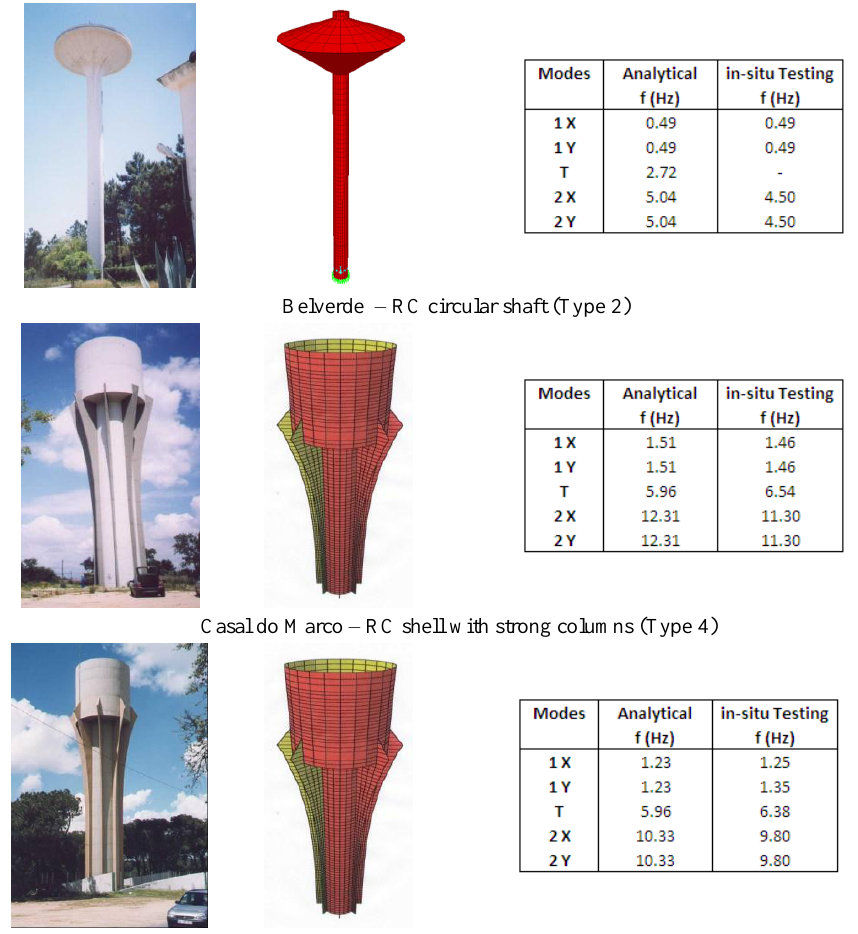
Fig. 6. Comparison between the analytical and in-situ testing frequencies. (The standard deviation of the analytical model is zero because materials and geometry are treated as deterministic; for the in-situ testing, the standard deviation is on the order of 0.05 Hz depending on the uncertainty of the water